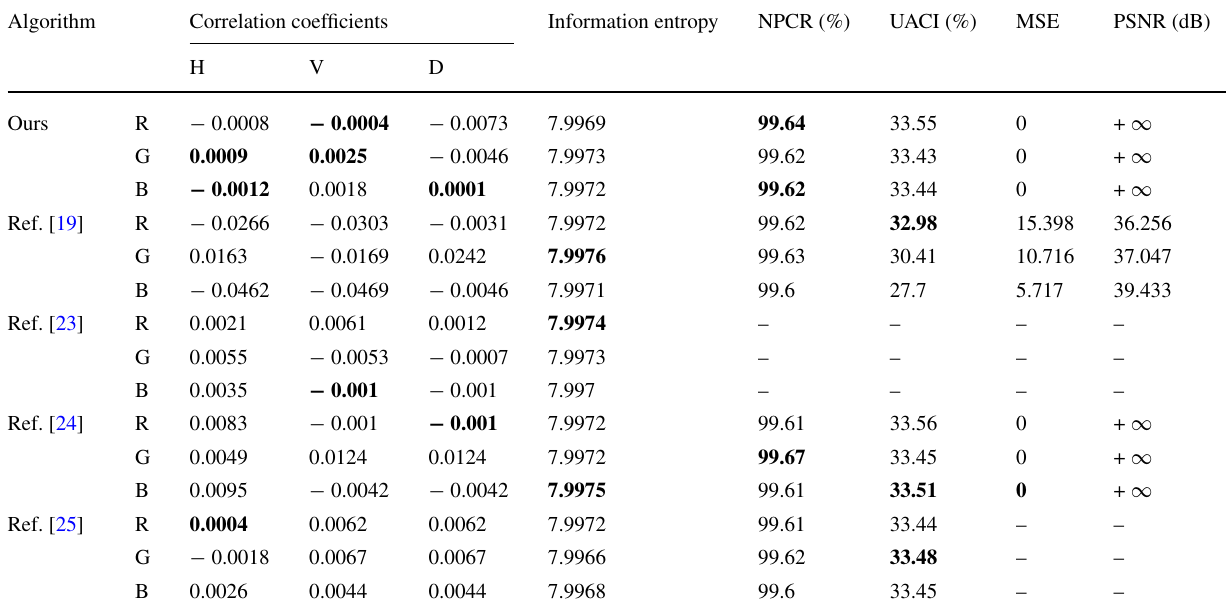
Table 15 Comparing results of key space, correlation coefficients and information entropy Algorithm Correlation